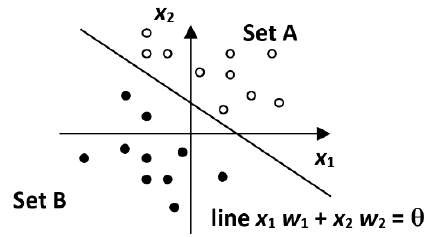
Figure 8. Data classification.